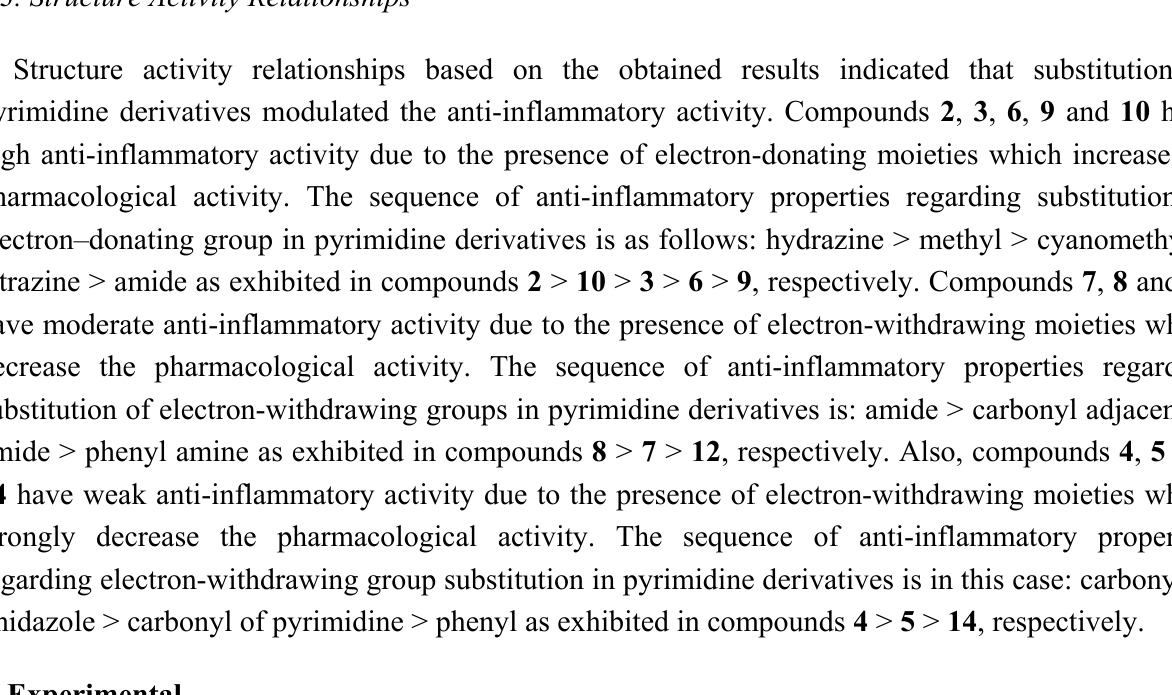
Table 3. Acute toxicity (LD